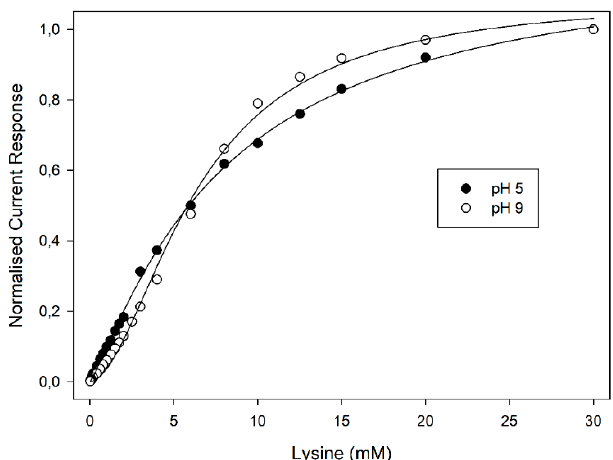
Figure 3. Normalised current responses due to injections of L-lysine standard solutions at the amperometric enzyme electrode as a function of L-lysine concentration at pH 5 ( • ) and pH 9 (o). Continuous lines refer to Hill fitting of data. Flow rate: 1 mL min − 1 ; other experimental conditions are described in the Materials and Methods section.